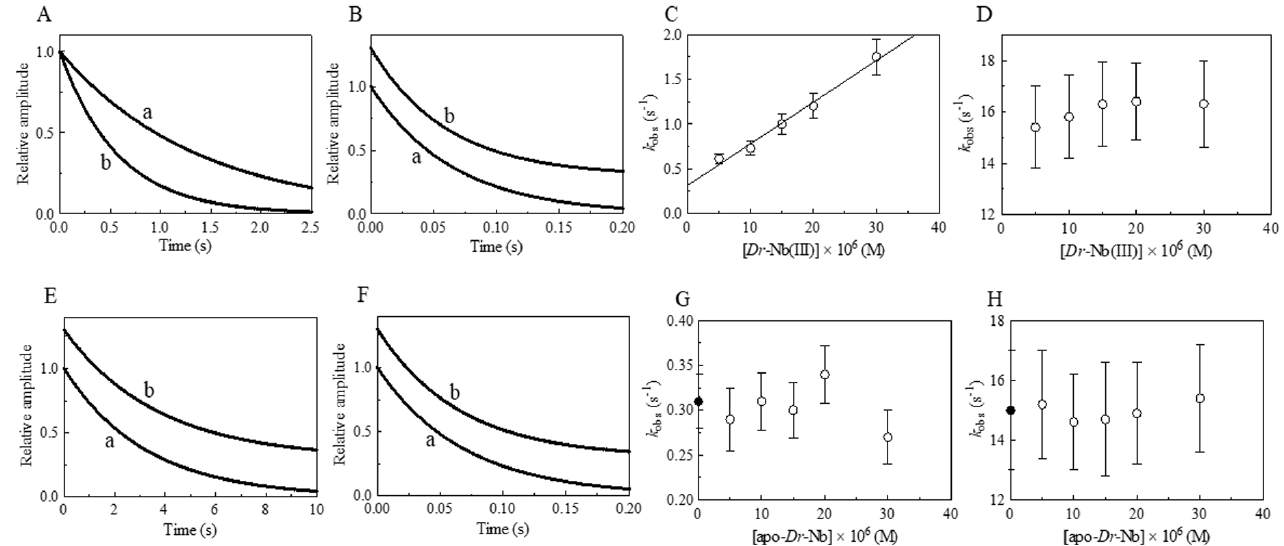
Figure 2. Effect of Dr -Nb(III) on the kinetics for peroxynitrite isomerization, at pH 7.0 and 22.0 °C. ( A ) Averaged time courses of the Dr -Nb(III)-catalyzed isomerization of peroxynitrite in the absence of CO 2 . The time course analysis according to Equation (1) allowed us to determine the following values of k obs : trace a, 7.3 × 10 − 1 s − 1 , R = 0.998; trace b, 1.8 s − 1 , R = 0.999. The Dr -Nb(III) concentration was: trace a, 1.0 × 10 − 5 M; trace b, 3.0 × 10 − 5 M. ( B ) Averaged time courses of the Dr -Nb(III)-catalyzed